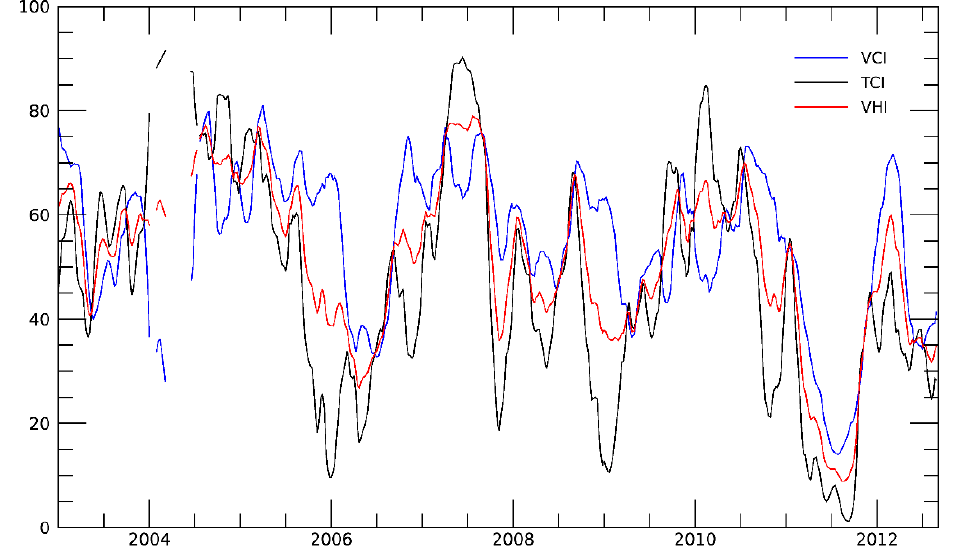
Figure 4. Vegetation health time series of Texas from January 2003 to September 2012, stressing the 2011 drought in this state.